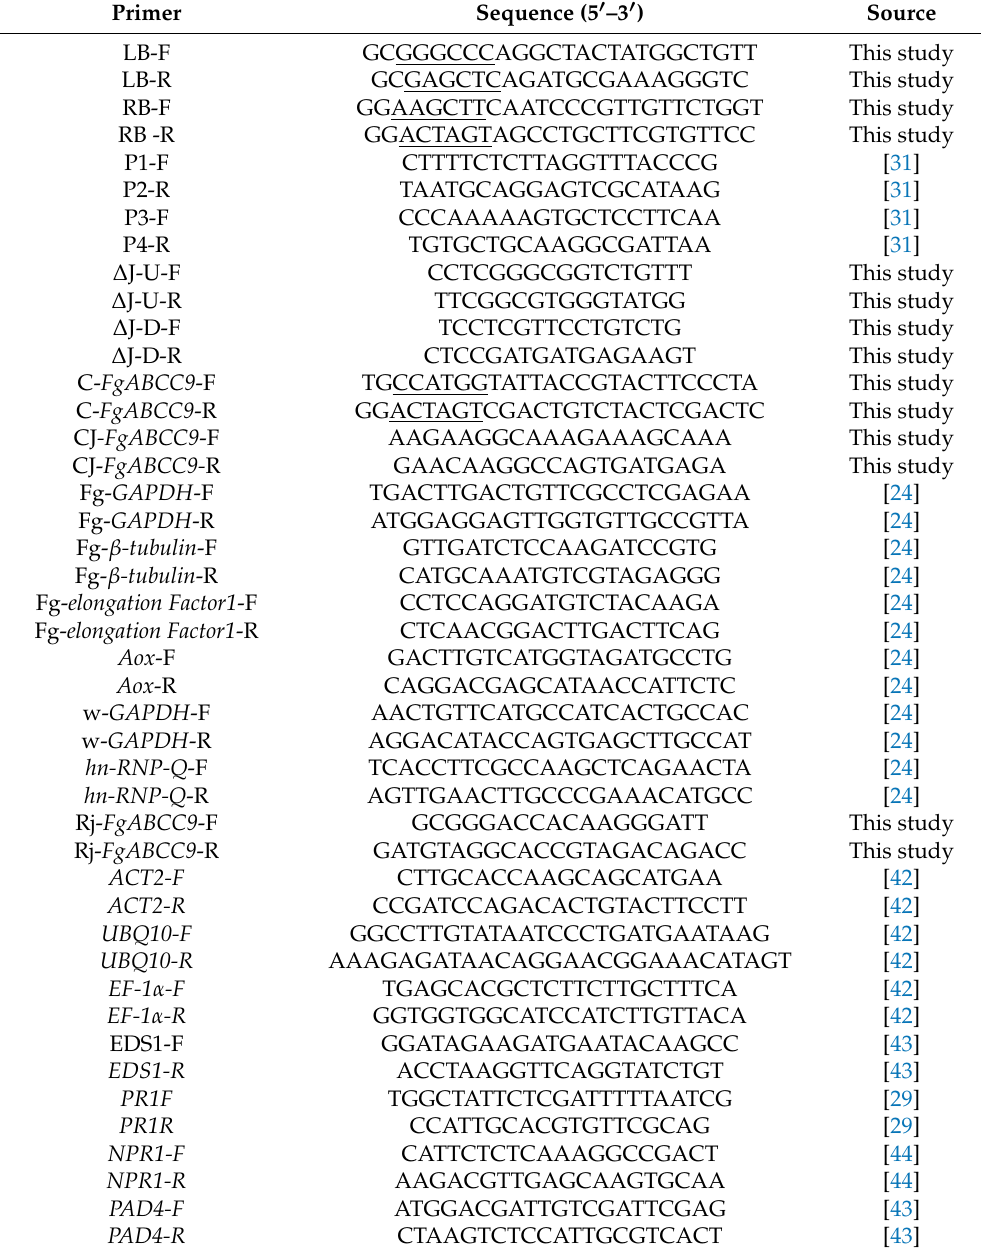
Table 1. Primers used in this